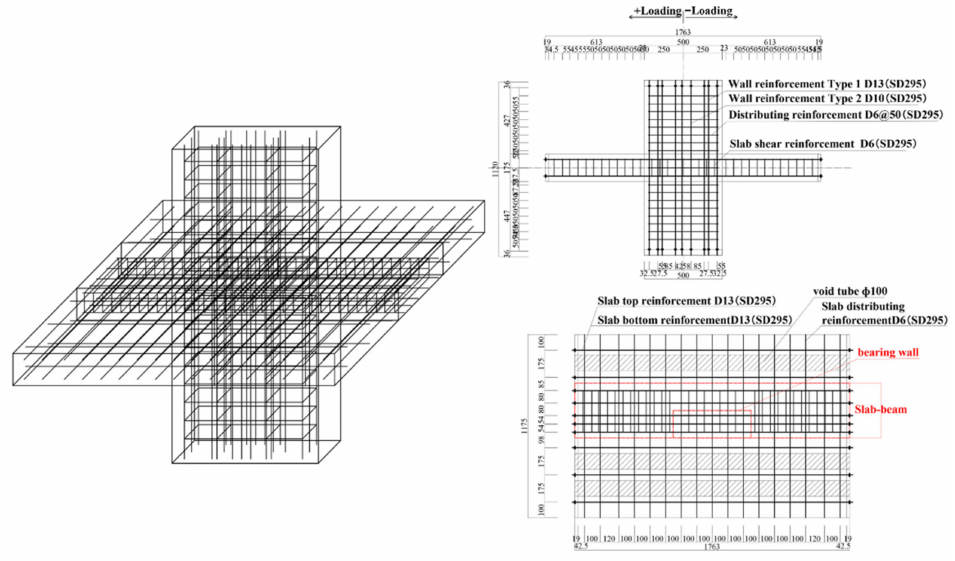
Figure 8. Design details for both-slab specimen (dimensions in mm) [6,7].